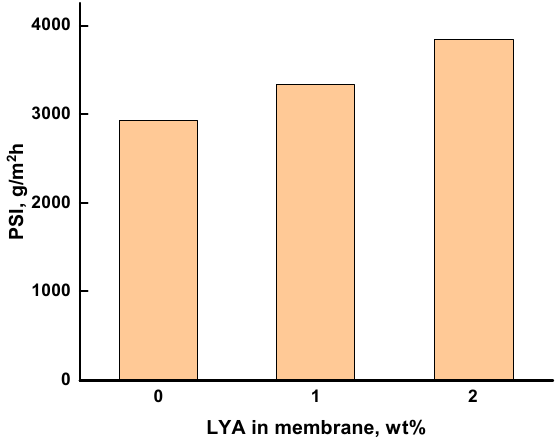
Figure 12. Pervaporation separation index ( PSI ) vs. the LYA content in the membrane during pervaporation of the methanol ‒ cyclohexane mixture (20 wt%). Thus, the use of layered perovskite oxide as a modifier of a polymer membrane is promising for increasing the effectiveness of the process.